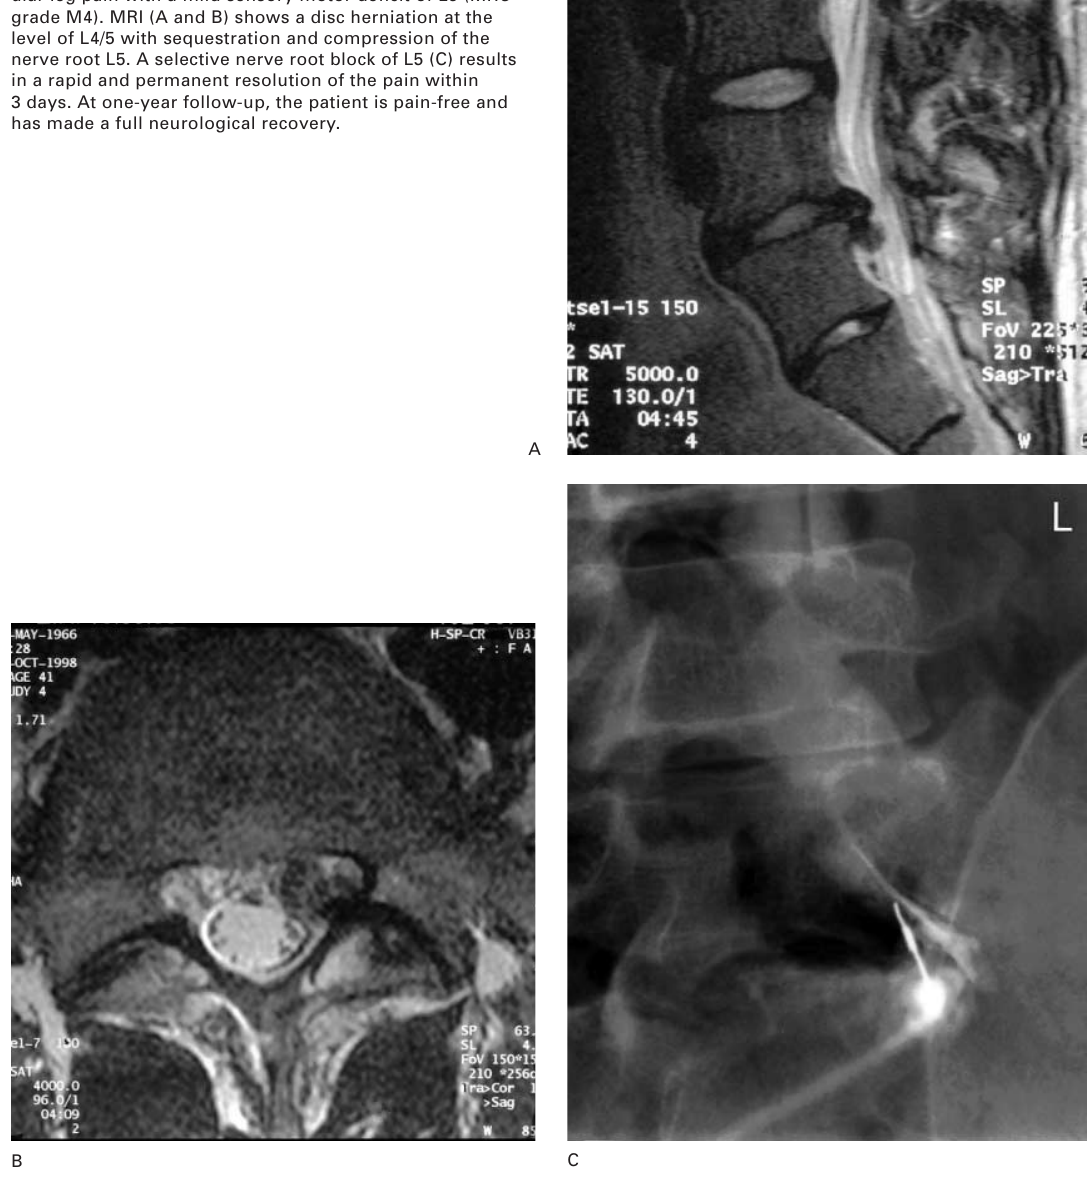
Figure 3 Thirty-five-year-old patient with acute onset of severe radic- ular leg pain with a mild sensory motor deficit of L5 (MRC grade M4). MRI (A and B) shows a disc herniation at the level of L4/5 with sequestration and compression of the nerve root L5. A selective nerve root block of L5 (C) results in a rapid and permanent resolution of the pain